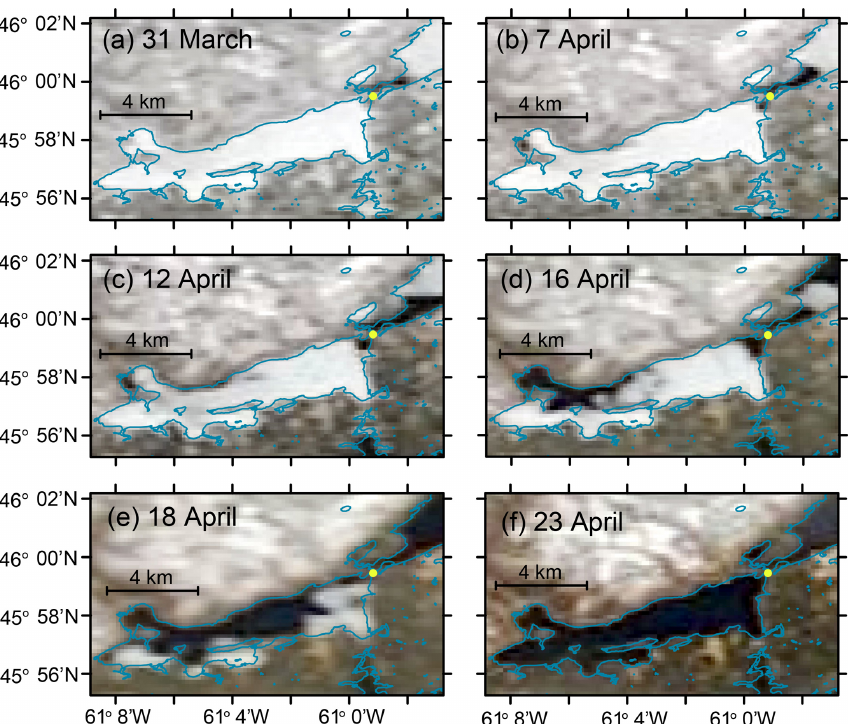
Figure 2. Satellite images showing changes in ice cover in Whycocomagh Bay. MODIS Terra true color images showing changes ice cover during the time series between 31 March and 23 April. Little Narrows is indicated with a yellow circle in all images. Ice cover retreated most rapidly between 12 and 20 April. Shoreline data (blue lines) are from GeoGratis/Natural Resources Canada (http://geogratis.gc.ca, last access: 27 August 2019) and satellite data are from NASA Worldview (http://worldview.earthdata.nasa.gov, last access: 27 August